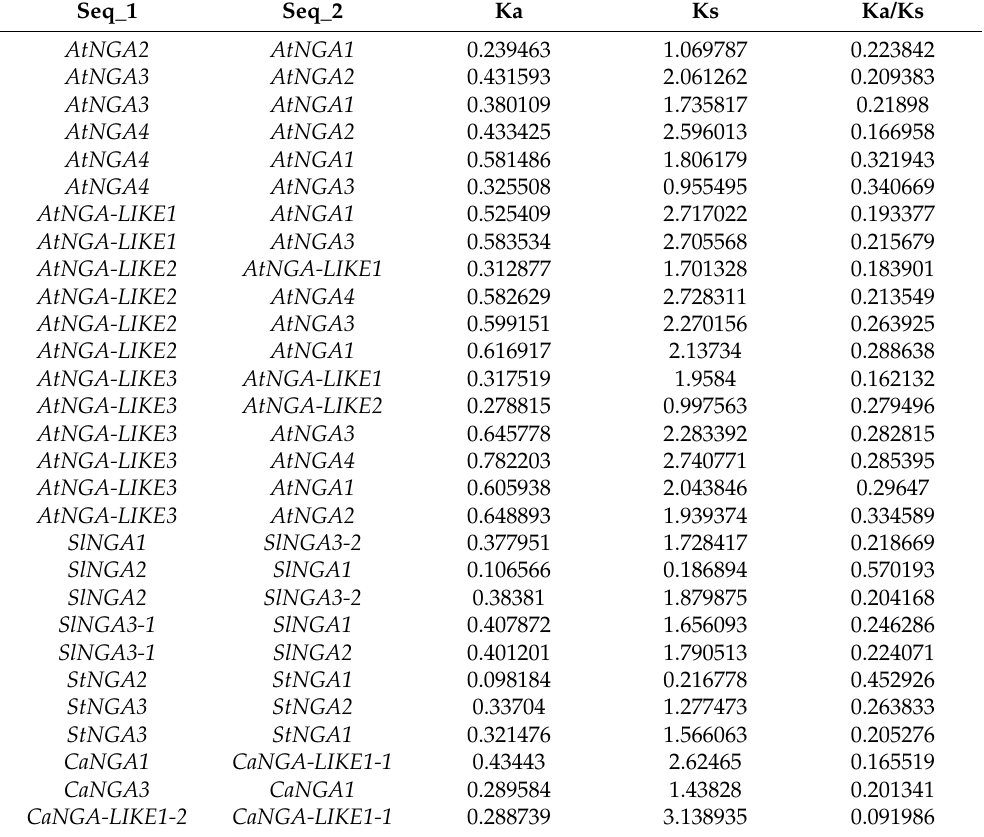
Table 3. Synonymous and non-synonymous substitutions in Arabidopsis and Solanaceae members (tomato, potato, and capsicum).